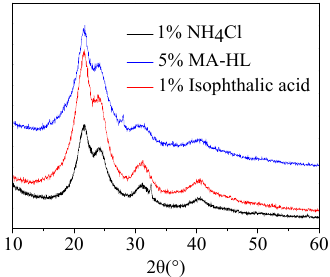
Figure 4. XRD patterns of UF resins with different additives.